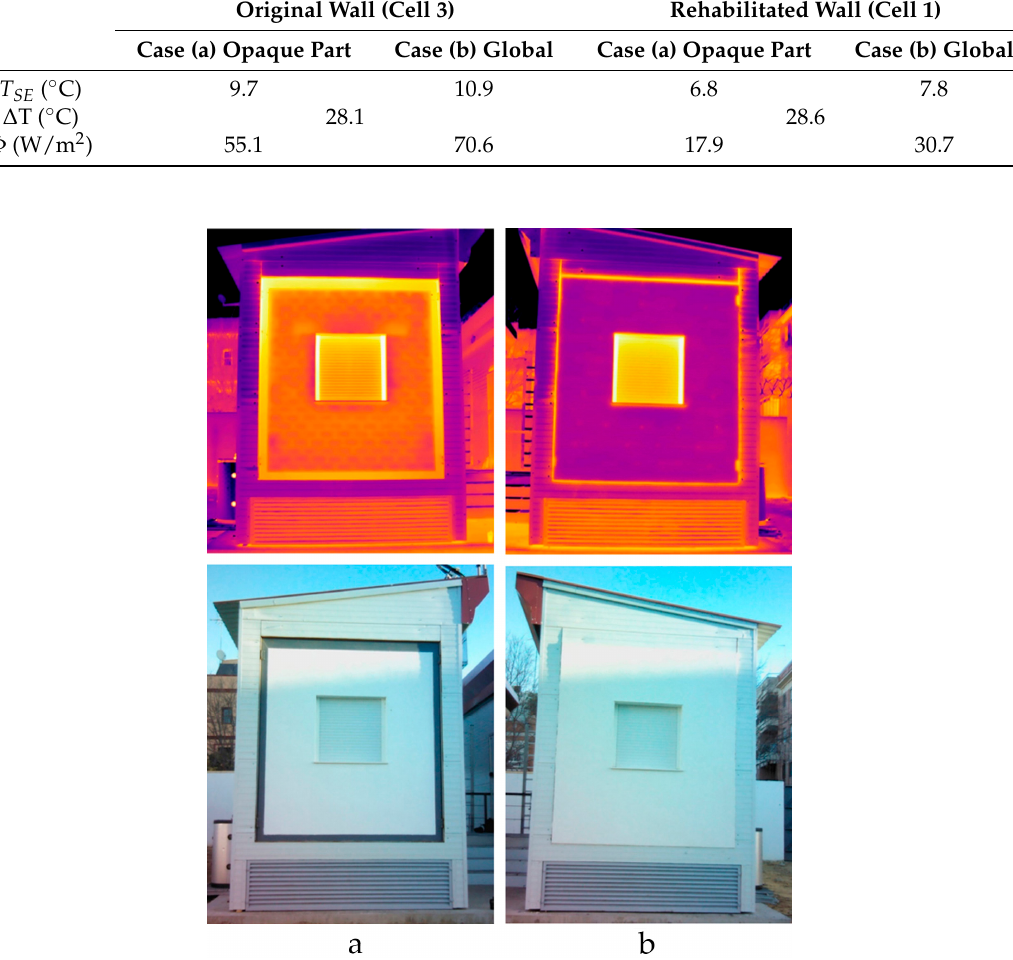
Figure 6. Infrared and visual images of the test cells facing south. ( a ) non-retrofitted building envelope (cell 3); ( b ) retrofitted solution with ETICS (cell 1). (cell 3); ( b ) retrofitted solution with ETICS (cell